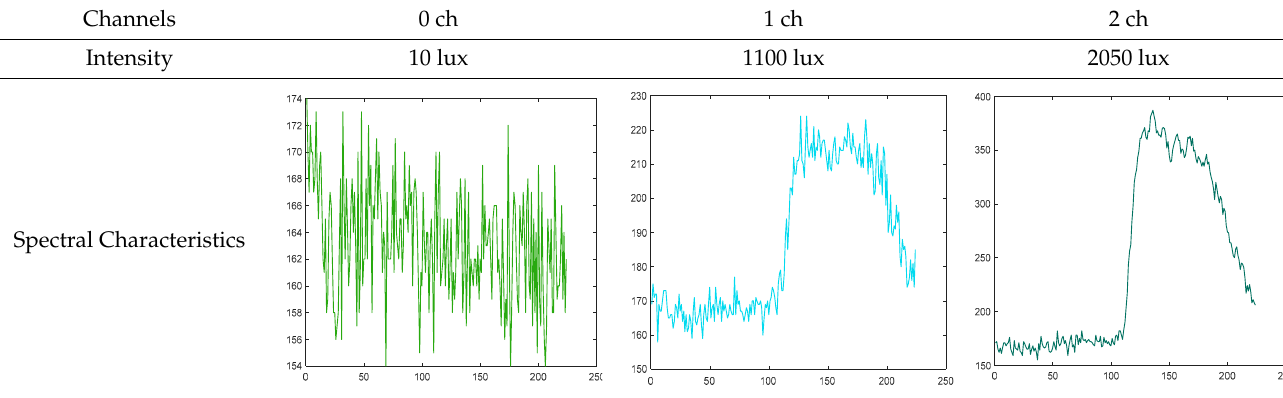
Table 2. Light intensity and spectral characteristics by number of light source channels.